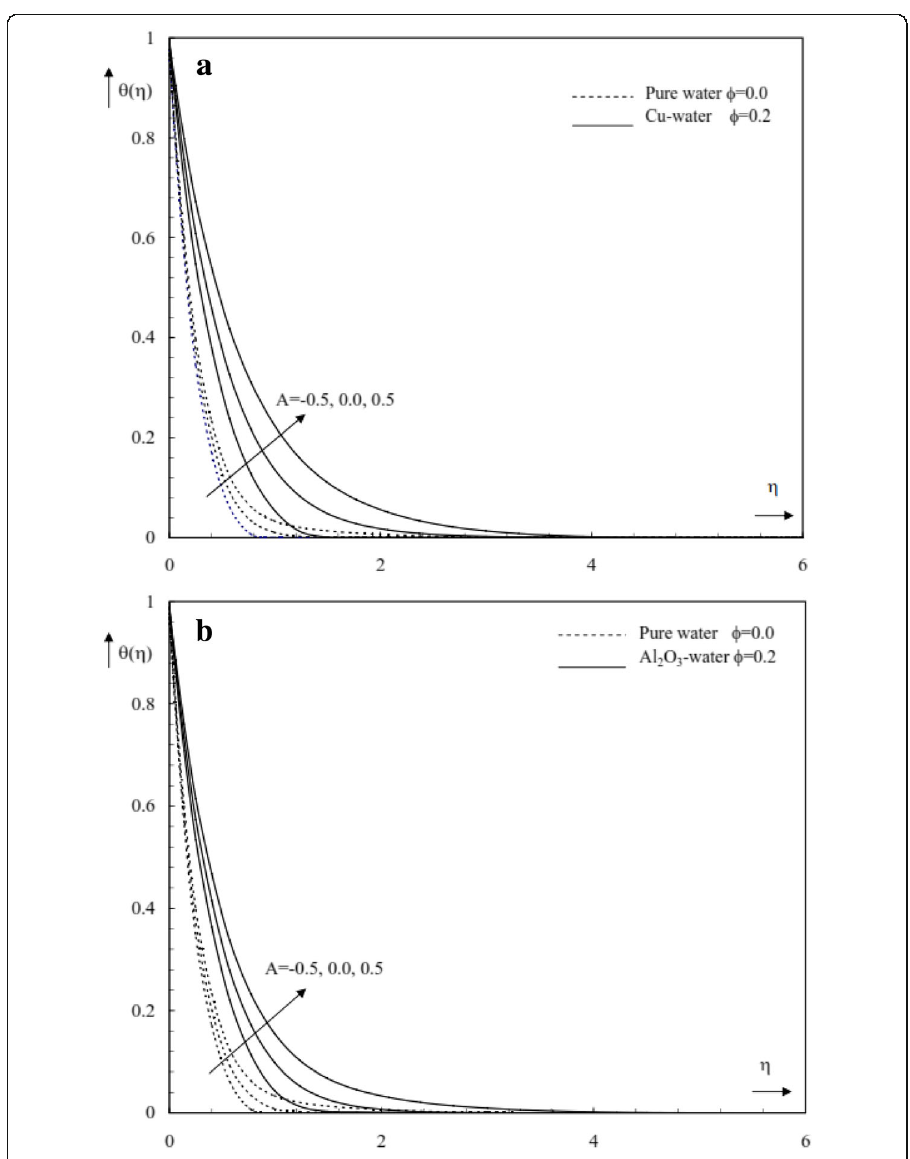
Fig. 10 Effects of ϕ and A on temperature distribution θ ( η ) for S = M = f w = 0.1 and B = λ = 0.5 for a Cu- water and b Al 2 O 3